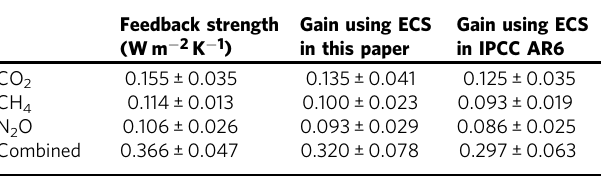
Table 1 Feedbacks estimated from D-O events, with 95% con fi dence